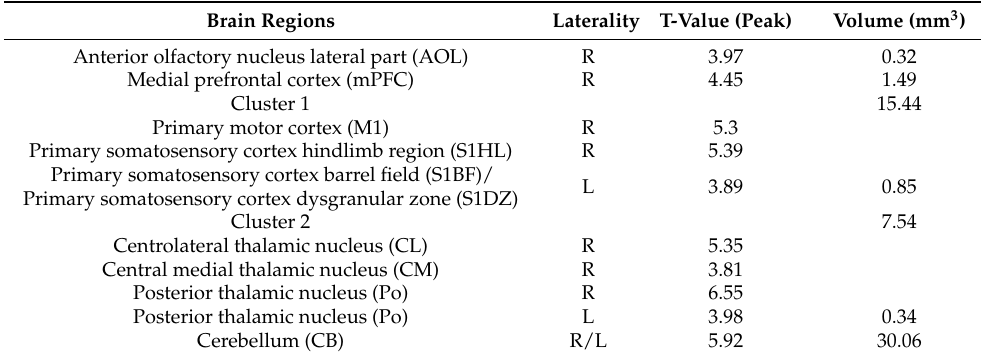
Table 1. Regions of the brain activated in response to mechanical allodynia in a neuropathic pain rat model.